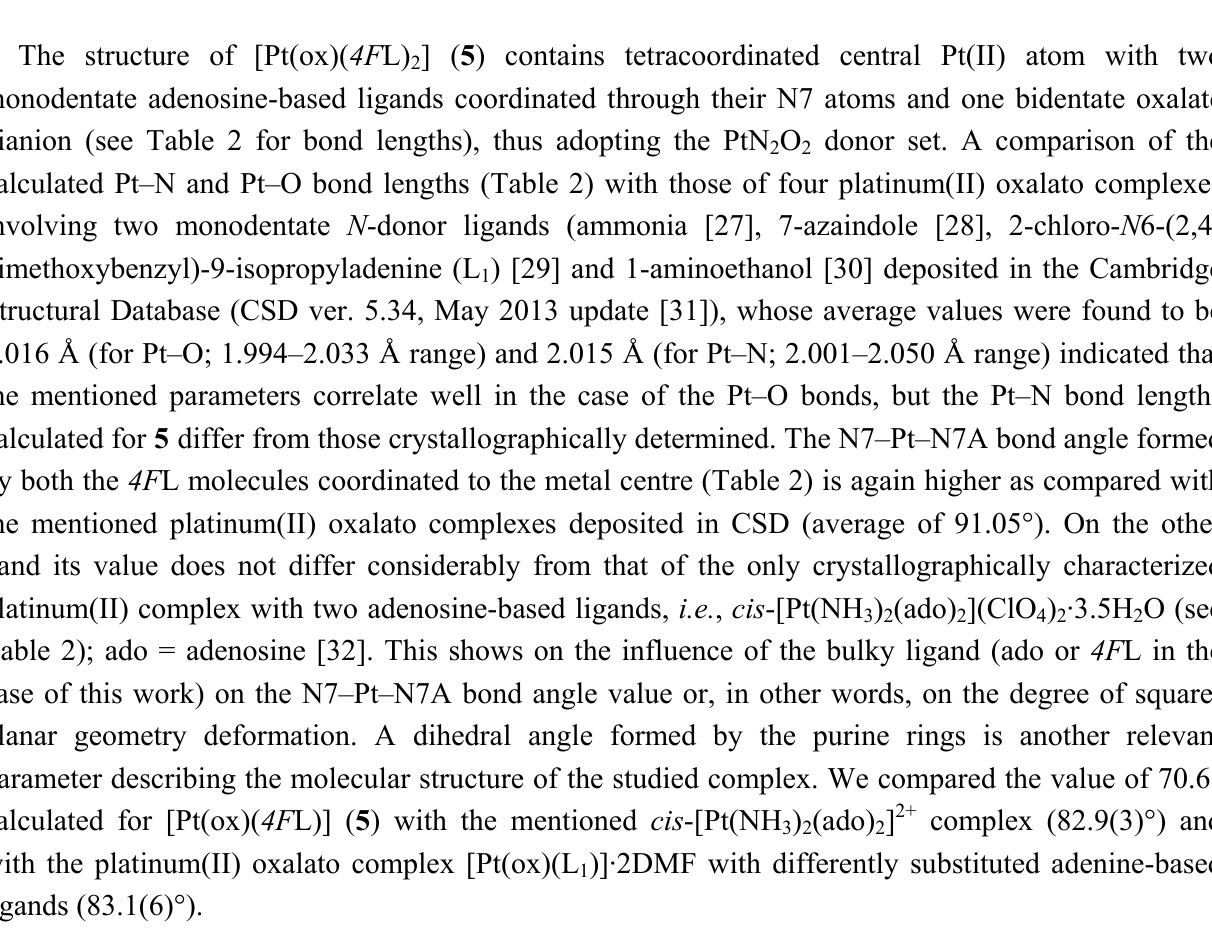
Table 2. Selected interatomic parameters as DFT and DFT-D3 calculated (B3LYP functional, LANLTZ/6-311G** basis sets) for the complex [Pt(ox)( 4F L)] ( 5 ) and their comparison with those crystallographically determined for cis -[Pt(NH (ado = adenosine; ref. [32]) and [Pt(ox)(L 9-isopropyladenine; ref.